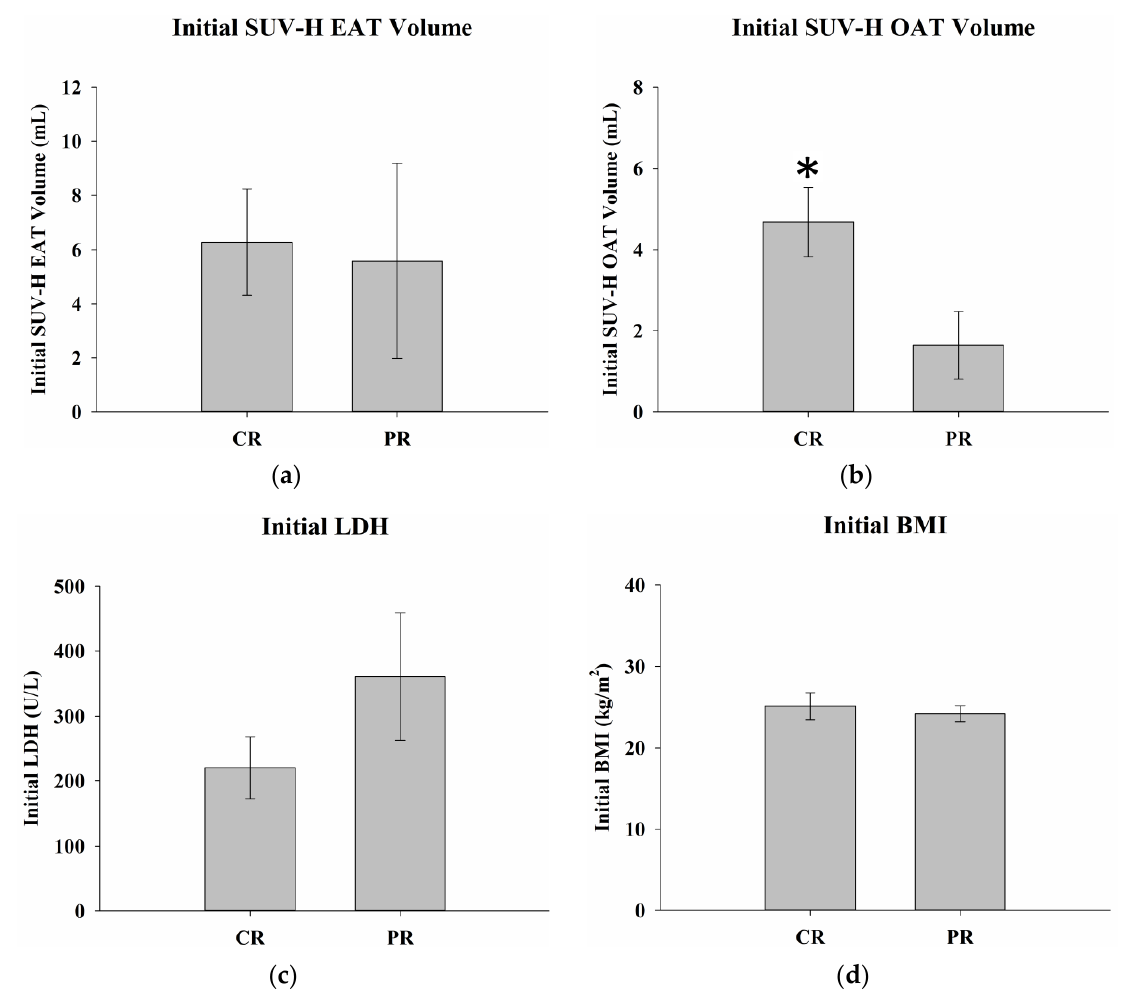
Figure 7. Initial SUV-H EAT and SUV-H OAT volumes, serum LDH levels, and BMI in complete and partial responders. There were no significant differences in ( a ) the SUV-H EAT volume, ( c ) serum LDH levels, or ( d ) BMI between complete and partial responders before treatment, with p values of 0.86, 0.18, and 0.64, respectively. ( b ) Greater initial SUV-H OAT volume is observed in complete responders than in partial responders ( p = 0.02). * Differences are significant at the 0.05 level (two-tailed). SUV-H EAT, high standardized uptake value epicardial adipose tissue; SUV-H OAT, high standardized uptake value orbital adipose tissue; LDH, lactate dehydrogenase; BMI, body mass index; CR, complete response; PR, partial response.